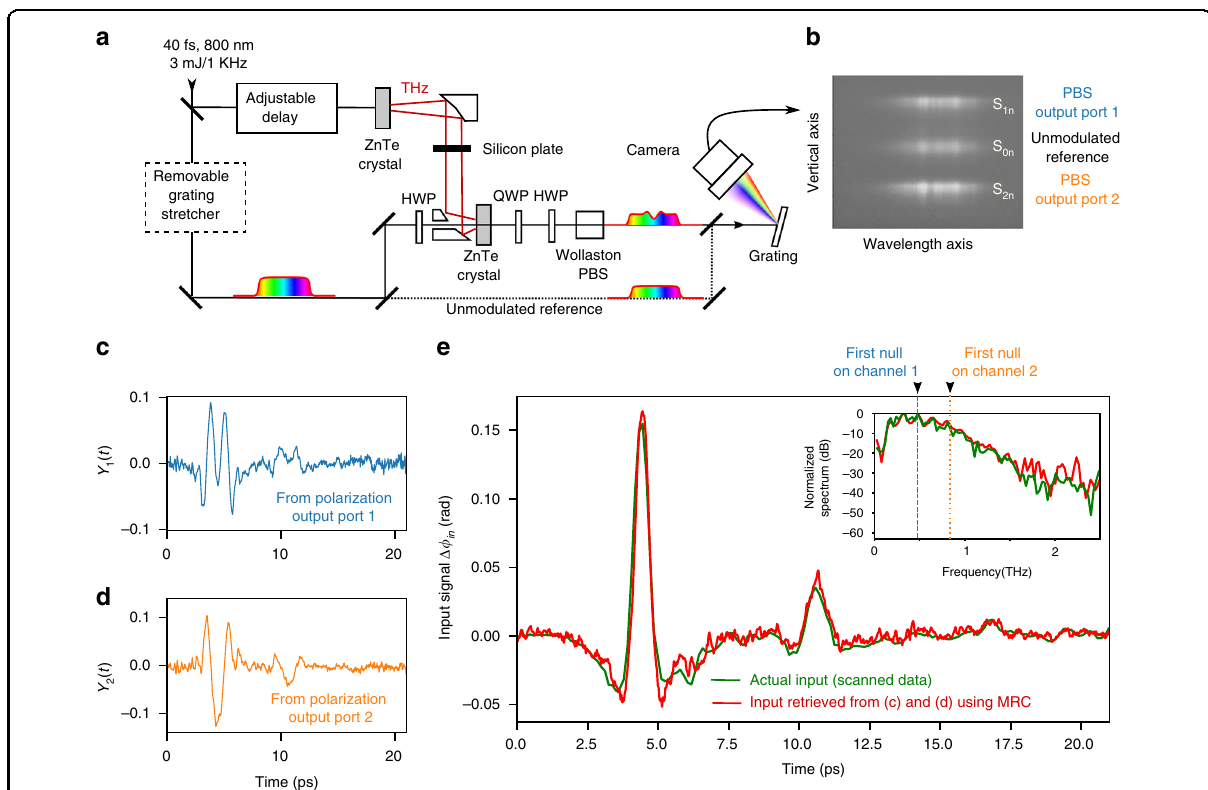
Fig. 3 Single-shot recording of free-propagating terahertz pulses over a window of the order of 20 ps. a DEOS experimental setup. ZnTe: 1 mm-thick, 110-cut Zinc Telluride crystal, HWP: Half-wave plates, QWP: Quarter-wave plate, PBS: Wollaston polarizing cube beam-splitter. The beams emerging from the PBS are in the plane perpendicular to the fi gure. b Raw camera image containing the single-shot spectra of the two polarization outputs S 1,2 n , and the unmodulated laser spectrum S 0 n . c , d EO signals on two polarizations channels (after background subtraction and normalization, see “ Materials and methods ” . e Single-shot input signal retrieved from ( c ) and ( d ) using the DEOS phase-diversity-based algorithm (red). Green trace: actual input, obtained using scanned electro-optic sampling. Inset: Fourier spectra of the two terahertz signals. Note that the classical (i.e., single channel) spectral decoding method would just provide the deformed signals ( c ) or ( d ), depending on the channel used. More generally, a classical single-channel method would provide an input signal with good fi delity only if its bandwidth is small compared to the location of the fi rst transfer function zero (dashed lines in the inset of ( e )), or if the signal bandwidth is within one of the lobes in the frequency response in Fig.